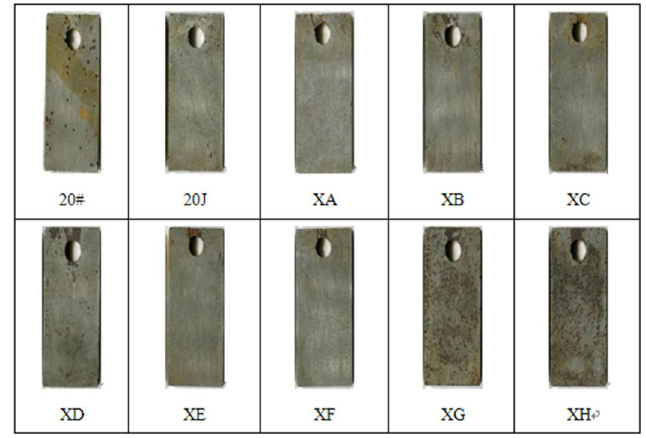
Figure 9. Morphology of coupons after the experiment.